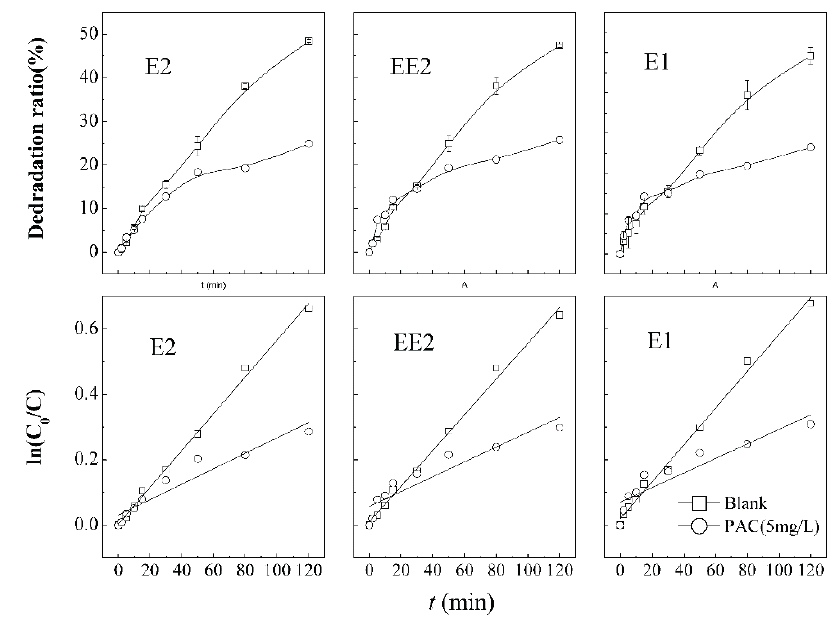
Figure 7. Degradation curves and first order kinetic models of SEs in the presence of Al 3+ .